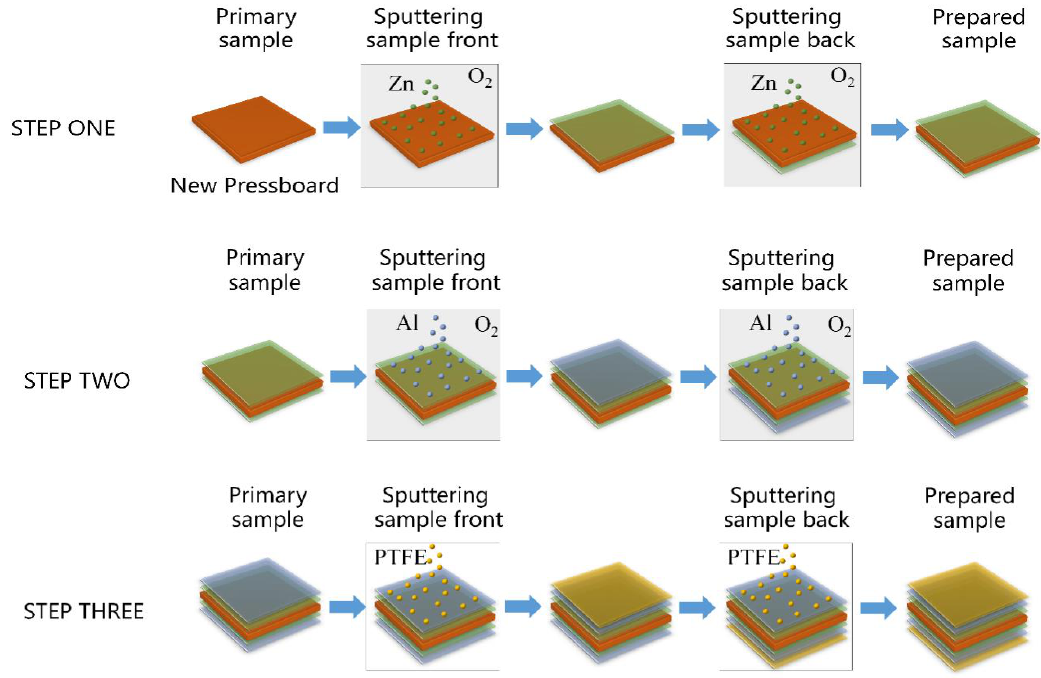
Figure 1. The process of magnetron sputtering of ZnO-Al 2 O 3 -PTFE multilayer films. Table 1. Sample preparation parameters.